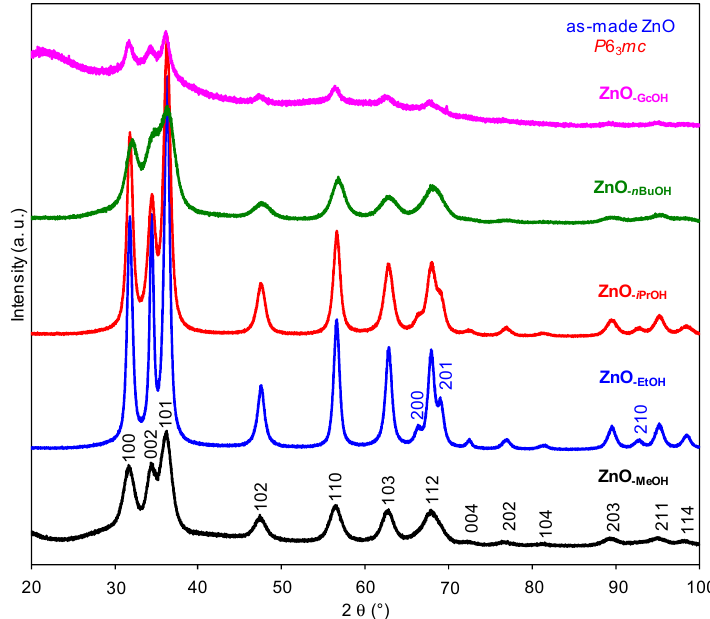
Figure 1. Wide-angle PXRD patterns of as-synthesized ZnO -ROH NPs by using Zn[N(SiMe 3 ) 2 ] 2 as a zinc precursor and alkyl alcohol as a reactant and solvent in the presence of stabilizer. Table 1. Particle size determined by TEM and XRD data and absorption peak from UV spectra.